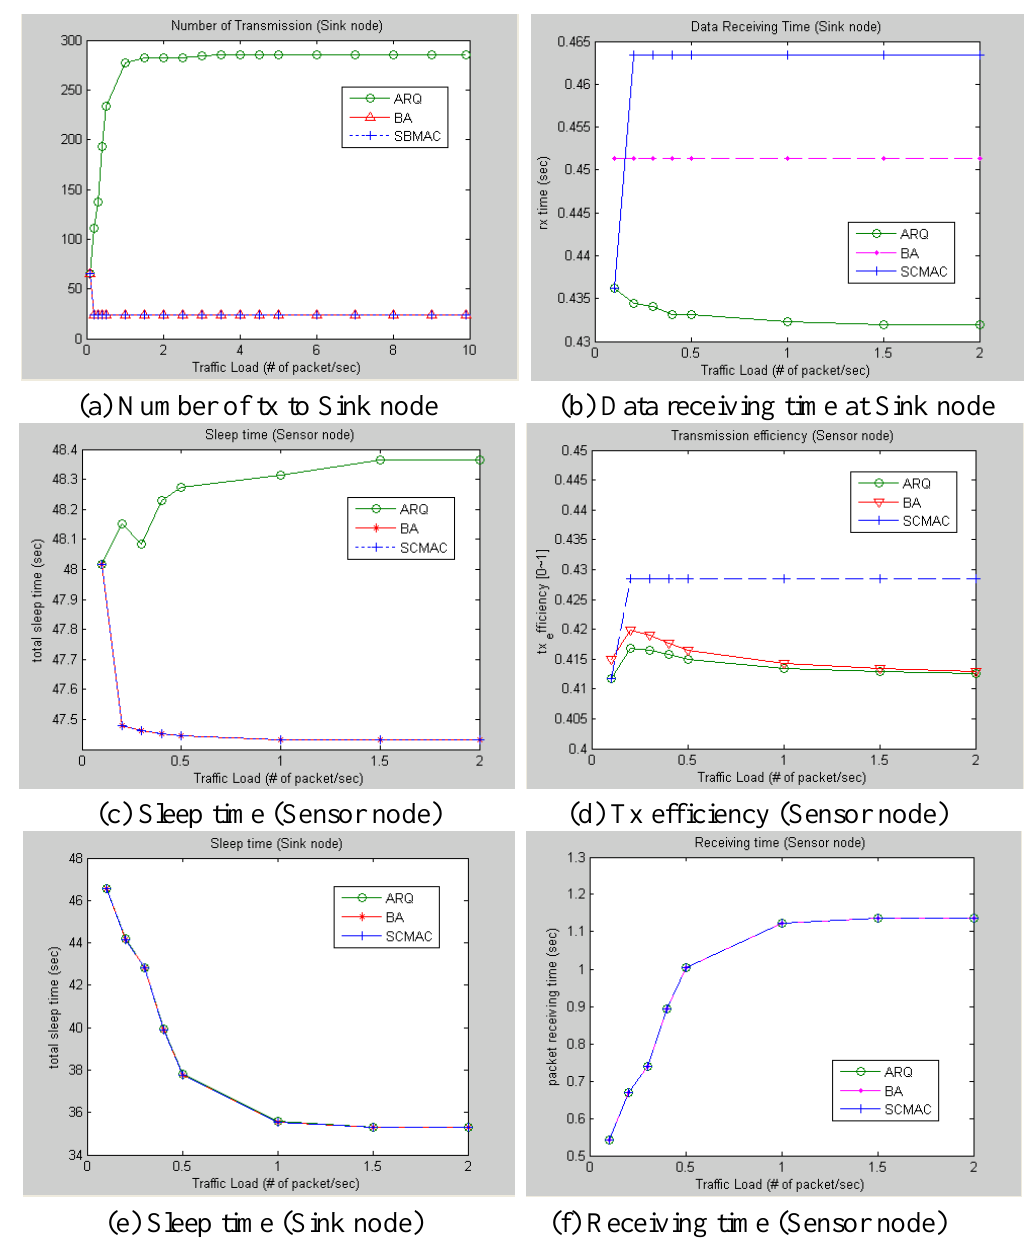
Figure 14. Simulation